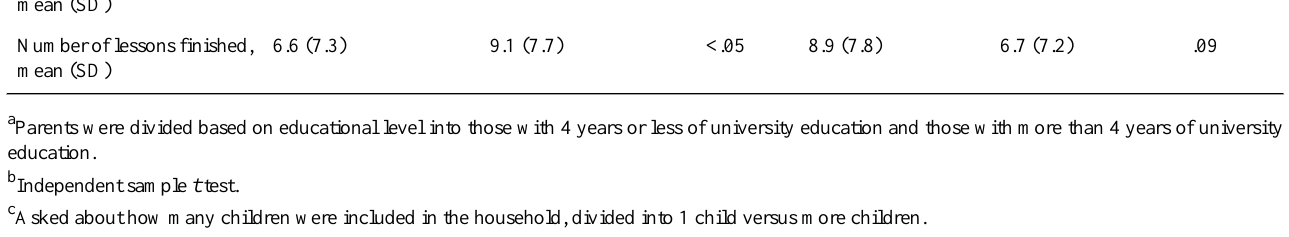
P value b Household with